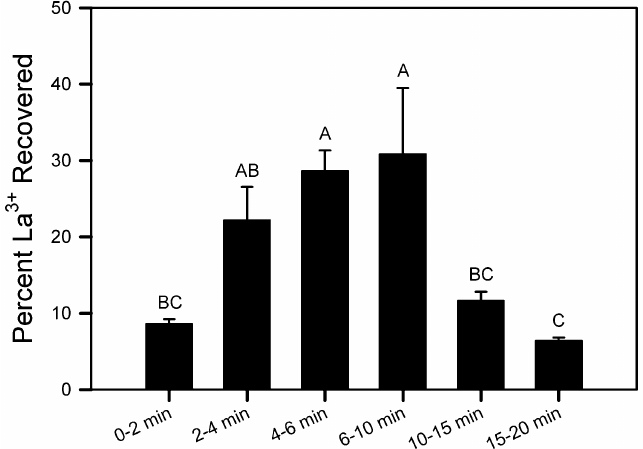
Figure 4. Metal recovery during ion flotation of La 3+ at ϕ = 10 measured by foam collected during different time frames of foam production. Bars represent averages and standard deviations of triplicate columns (n = 3). Bars not connected by the same letter indicate significant differences in removal percentage.